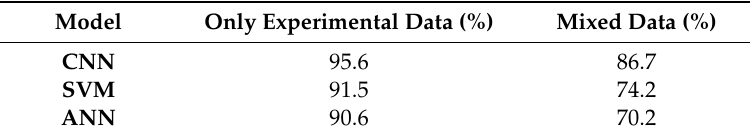
Table 3. Overall average accuracy comparison of training data.